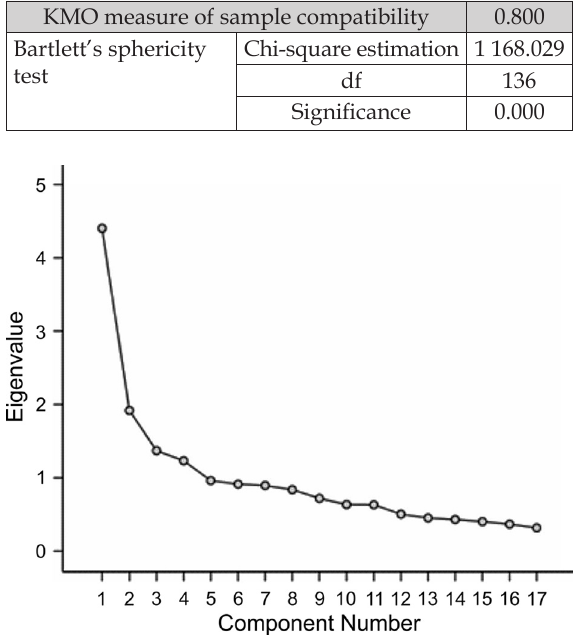
Table 4. kaiser-Mayer-Olkin and Bartlett tests.